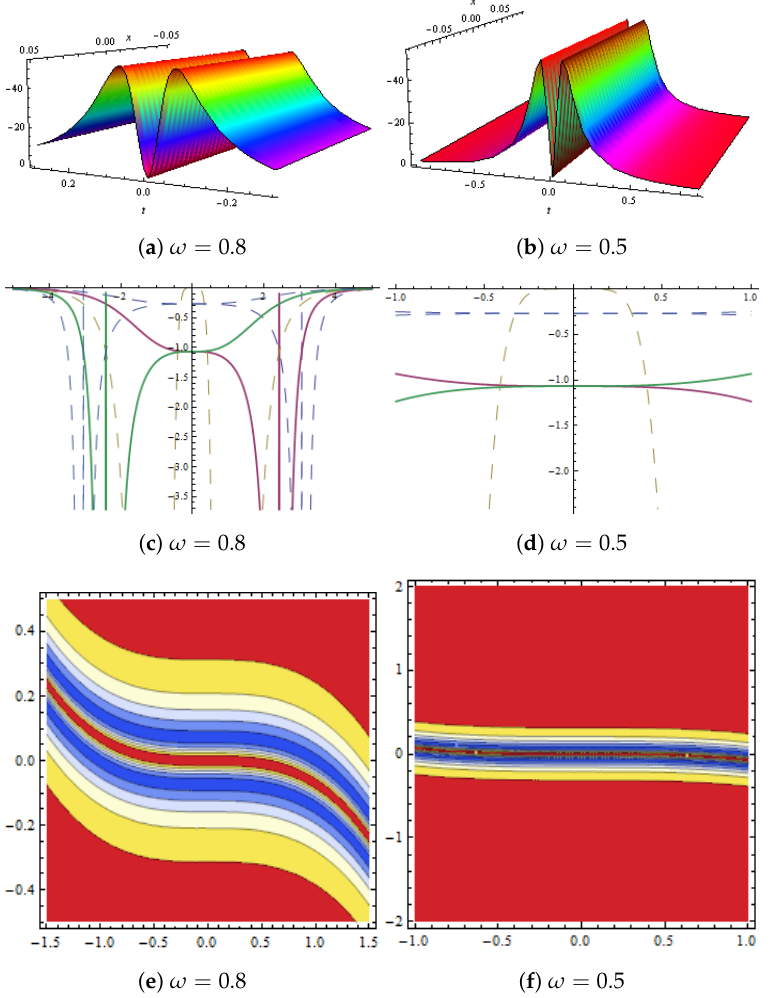
Figure 1. Show the behaviour of u ( x , t ) in Equation (20), it is presented with β 1 = 3.5, β 2 = 0.2, β 3 = 1.5, ζ = 0, l 2 = 0.3, Q = 2, r 1 = 1.5, w 2 = 2.5, w 3 = 7.3, w 4 = 1.9 and φ = 4.7. ( a , b ) shows 3D graphs presenting bright and dark faces for ω = 0.8 and ω = 0.5 respectively, ( c , d ) show 2D graphs for bright and dark faces for ω = 0.8 and ω = 0.5 respectively. ( e , f ) show contour graphs for bright and dark faces for ω = 0.8 and ω = 0.5